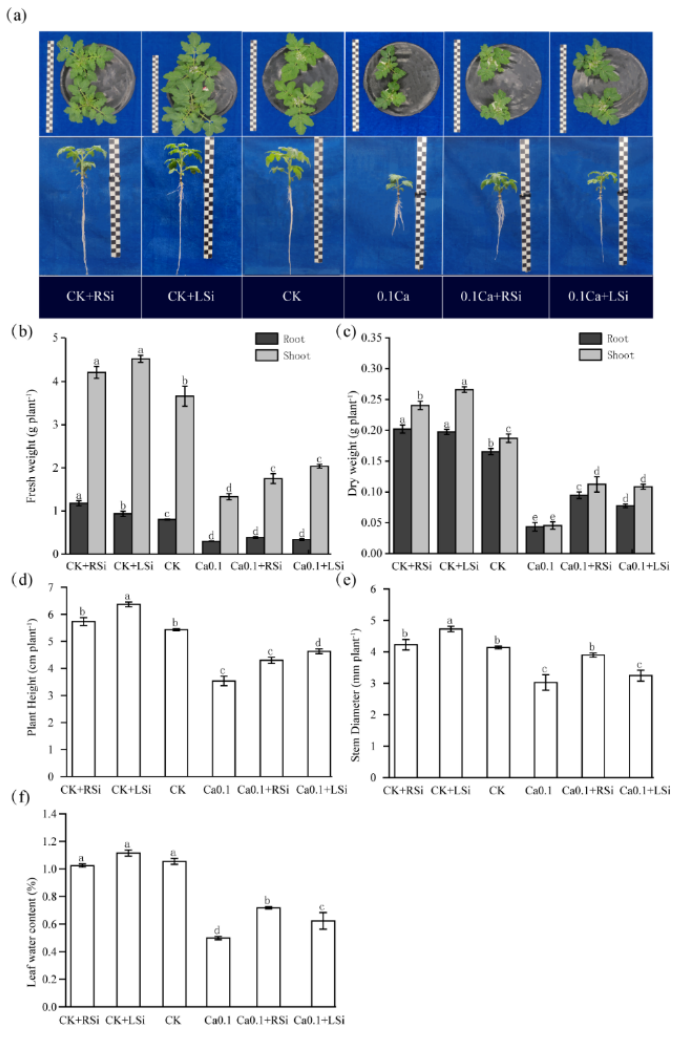
Figure 1. Effect of exogenous Si on growth parameters in tomato under low − calcium stress. ( a ) Plant morphologies of tomato seedlings after different treatments; ( b ) plant height; ( c ) stem diameter; ( d ) fresh weight; ( e ) dry weight; ( f ) leaf water content. The means of three replicates ± standard error is shown. The data were subjected to an ANOVA test to determine the LSD and bars superscribed by different letters are significantly different at p < 0.05. Standard errors are indicated by bars. CK + RSi: 4 mM Ca in Hoagland nutrient solution + root application of 1 mM Si; CK + LSi: 4 mM Ca in Hoagland nutrient solution + foliar application of 1 mM Si; CK: 4 mM Ca in Hoagland nutrient solution; 0.1Ca: 0.1 mM Ca in Hoagland nutrient solution; 0.1Ca + RSi: 0.1 mM Ca in Hoagland nutrient solution + root application of 1 mM Si; 0.1 Ca + LSi: 0.1 mM Ca in Hoagland nutrient solution + foliar application of 1 mM Si.